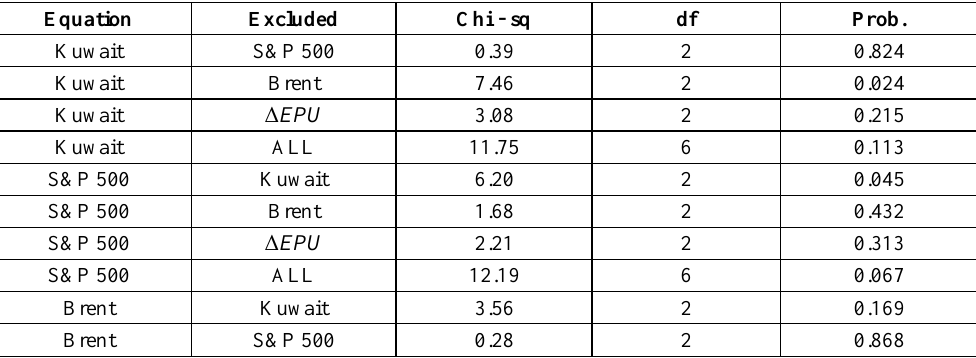
Table 6. Granger Causality Wald